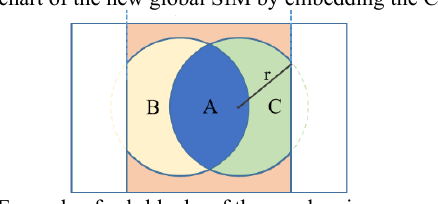
Fig. 1 Flowchart of the new global SfM by embedding the CRD